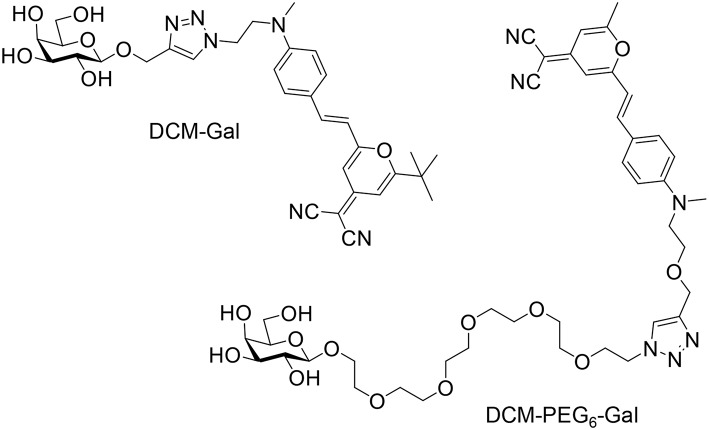
Structure of the glycoprobes used for self-assembly with thin-layer MnO2.